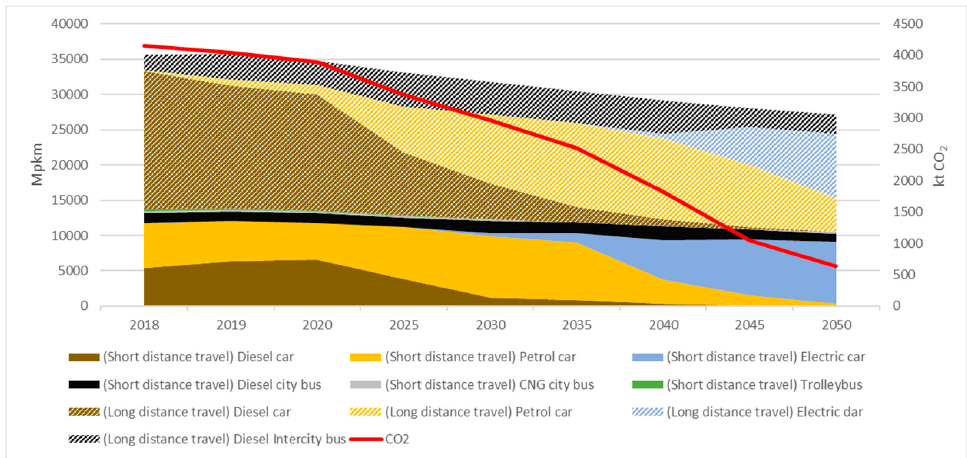
Figure 8. Distance traveled in MPkm by different transportation modes and CO 2 emissions from passenger road transport using a proposed modeling approach.